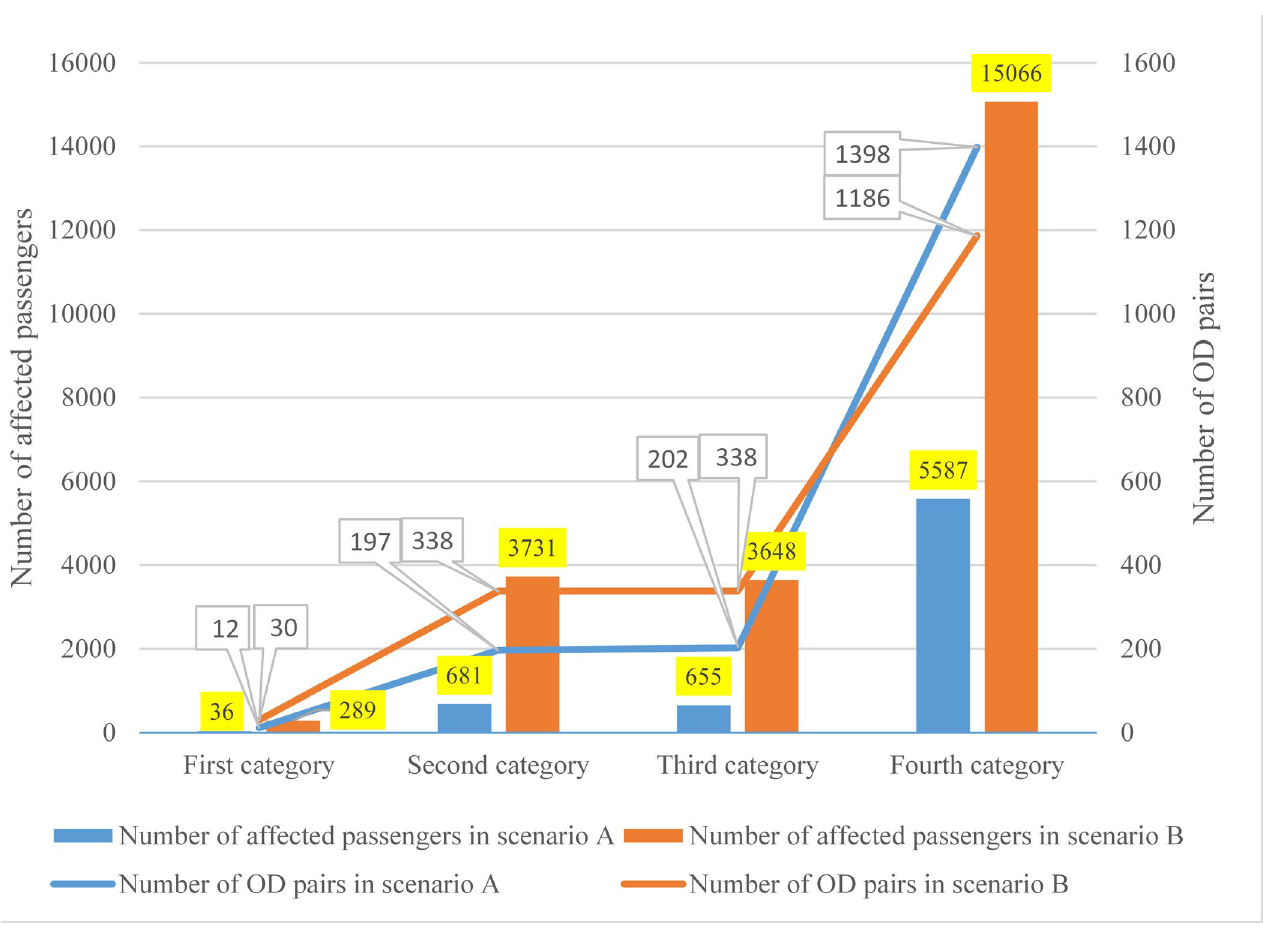
Figure 9. Number of affected rail passengers and OD pairs in different categories.